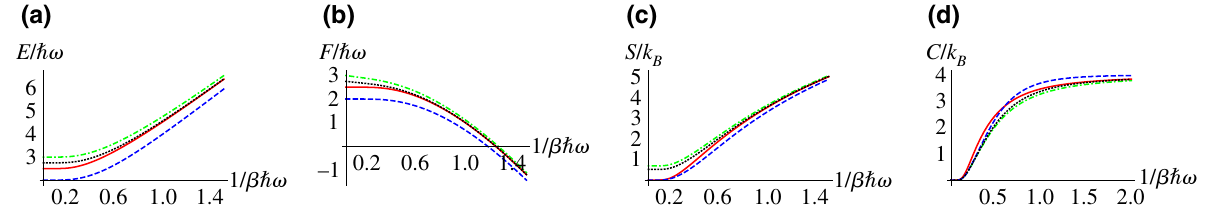
FIG. 6. Comparison of (a) internal energy, (b) free energy, (c) entropy, and (d) heat capacity of two topological anyons with phase parameter ν , against two statistical anyons using phase parameter p B = (ν − 1 ) 2 . The lines correspond to ν = 0, p B = 1 (blue, dashed), = 0 (green, dot dashed), ν = 1 / 2 (red, solid), and p ν = 1, p B